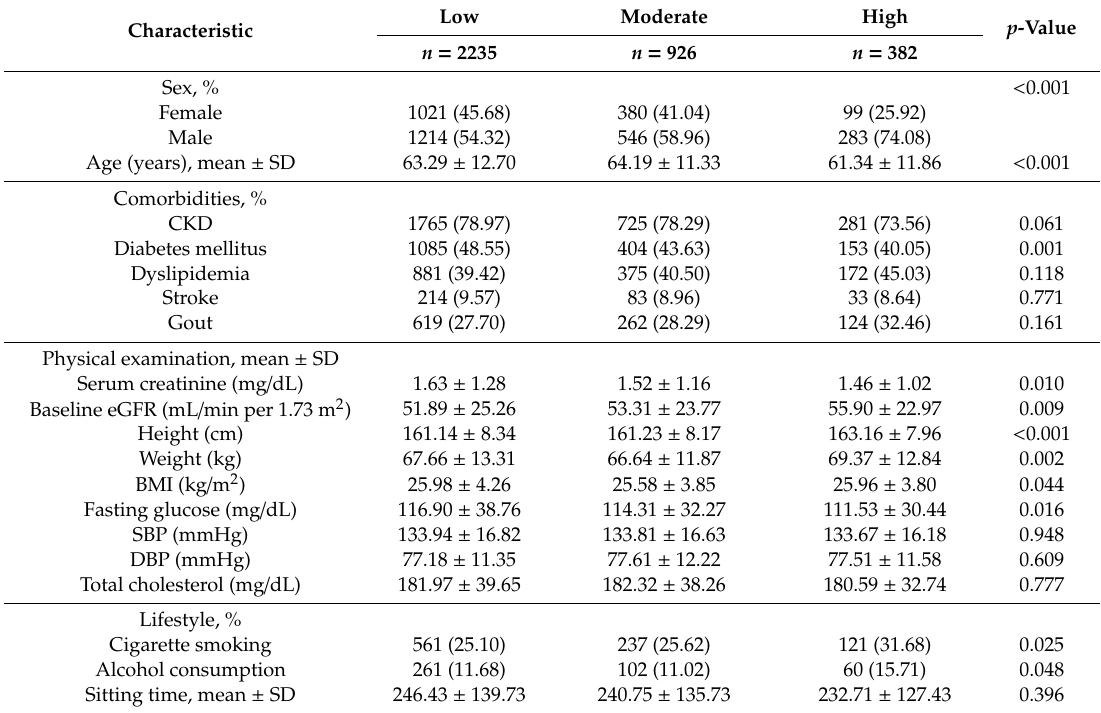
Table 2. Levels of physical activity by patient